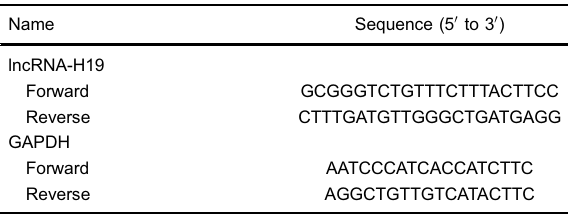
Table 3. Primer sequences used in real-time polymerase chain reaction